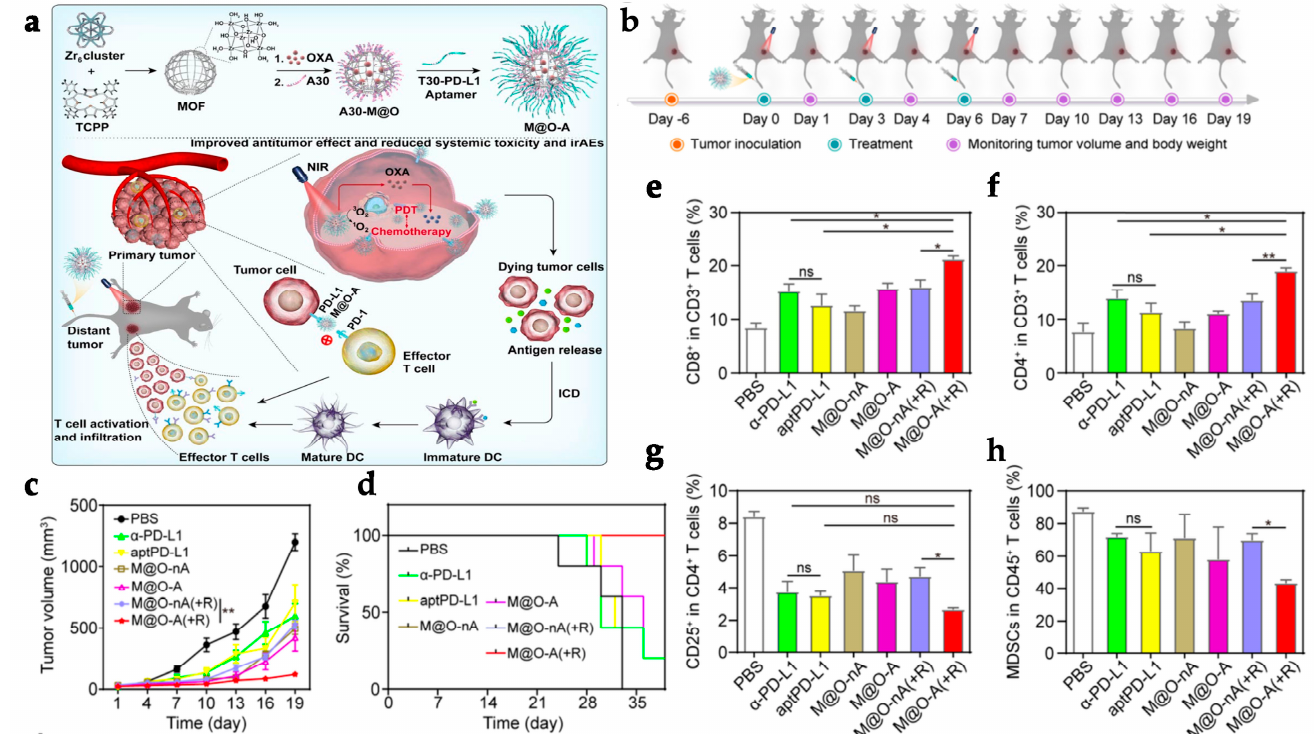
Figure 3. Representative example of an MOF used in synergetic PDT-immunotherapy. ( a ) M@A was synthesized by encapsulation of OXA in PCN-224 and subsequent adsorption of T30-PD-L1. M@A was designed for a combination of PDT, chemotherapy, and immunotherapy to improve ROS production and enhanced antitumor immune response. ( b ) MC38 tumor cells were inoculated in mice and grown to a tumor volume of 50–100 mm 3 . Mice were treated with 10 mg/kg MOF and irradiated or not with a laser at 640 nm (0.1 W/cm 2 ) for 30 min at days 6, 9, and 12 after inoculation. ( c ) Tumor growth curves of mice injected with different treatments and with or without irradiation. h ) Flow cytometry analysis of infiltrating ( e ) CD8 + T cells, ( f ) CD4 + T cells, ( g ) Treg cells and ( h )